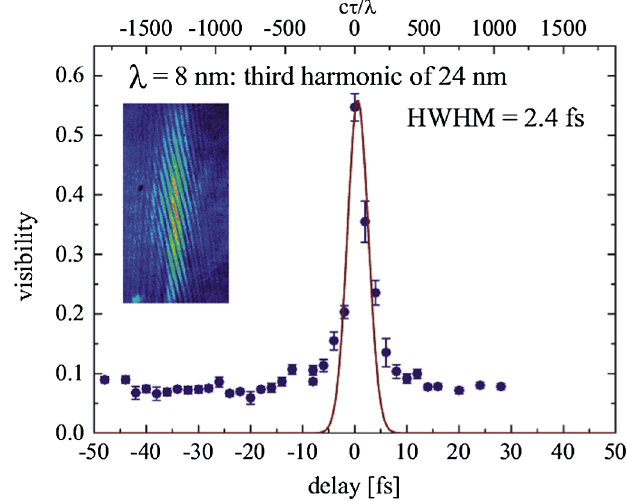
FIG. 10. Visibility as a function of pulse delay for (cid:1) ¼ 8 nm as the third harmonic of 24 nm fundamental wavelength. The inset shows interference fringes at zero delay with V ¼ 0 : 71 . A ¼ 2 : 4 fs is obtained in this case. The solid coherence time of (cid:2) c line is a Gaussian